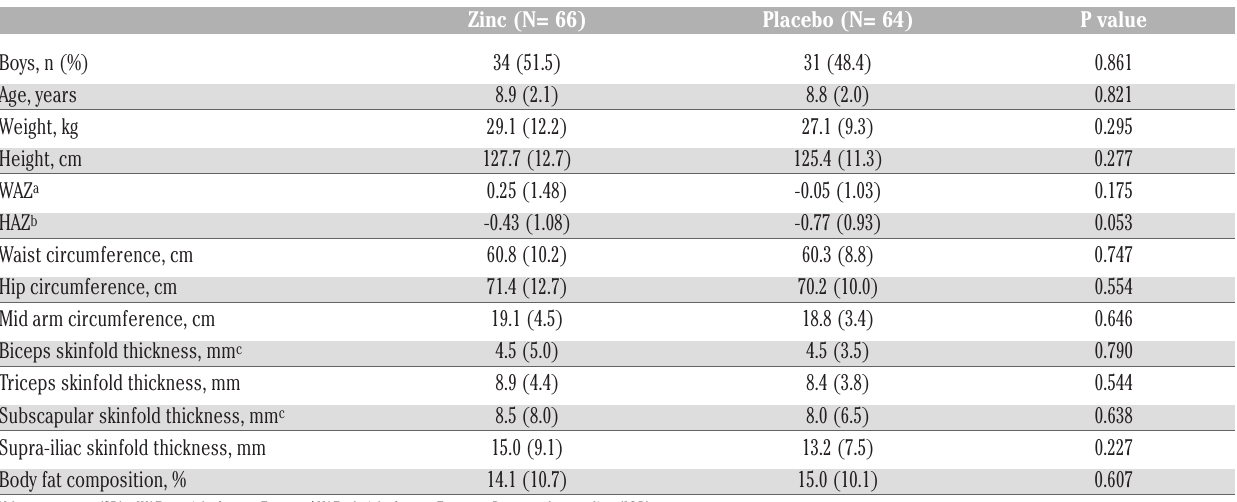
Table 1. Baseline characteristics and anthropometric data of the study population.